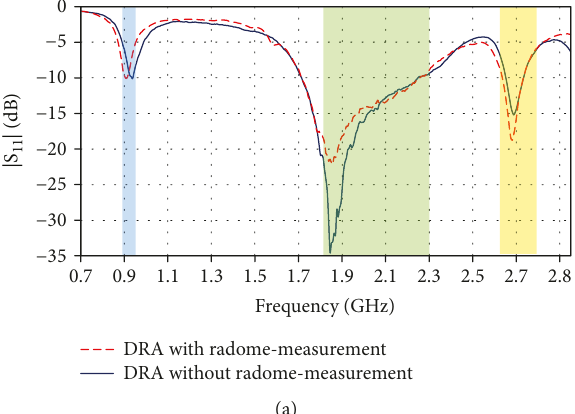
Figure 13: Radome e ff ect on the ∣ S e ffi ciency (b).